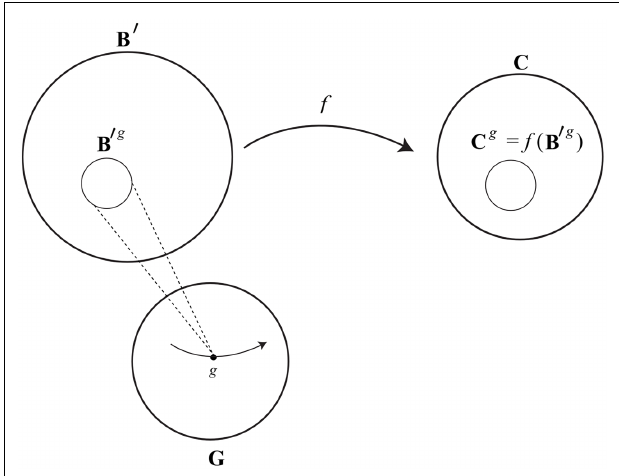
FIGURE 5 |A brain structure g ∈ G determines an accessible region B (cid:3) g ⊆ B (cid:3) , which in turn has its image C g under f in C. An open phase portrait φ g,e (not shown) defined on B (cid:7) g also has its image under f , yielding a phase portrait ψ g, e in C g . In this way phenomenological dynamics can be derived from neural